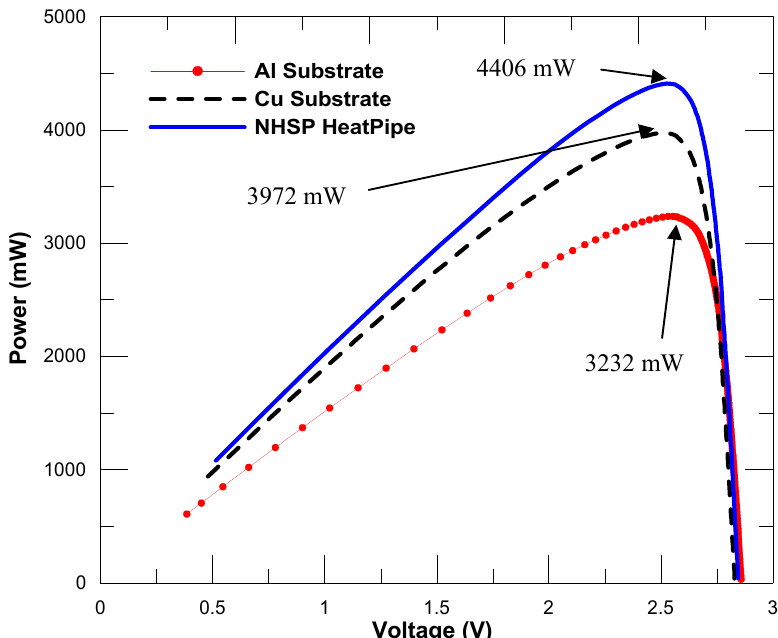
Figure 6. P/V curve of solar cell with different